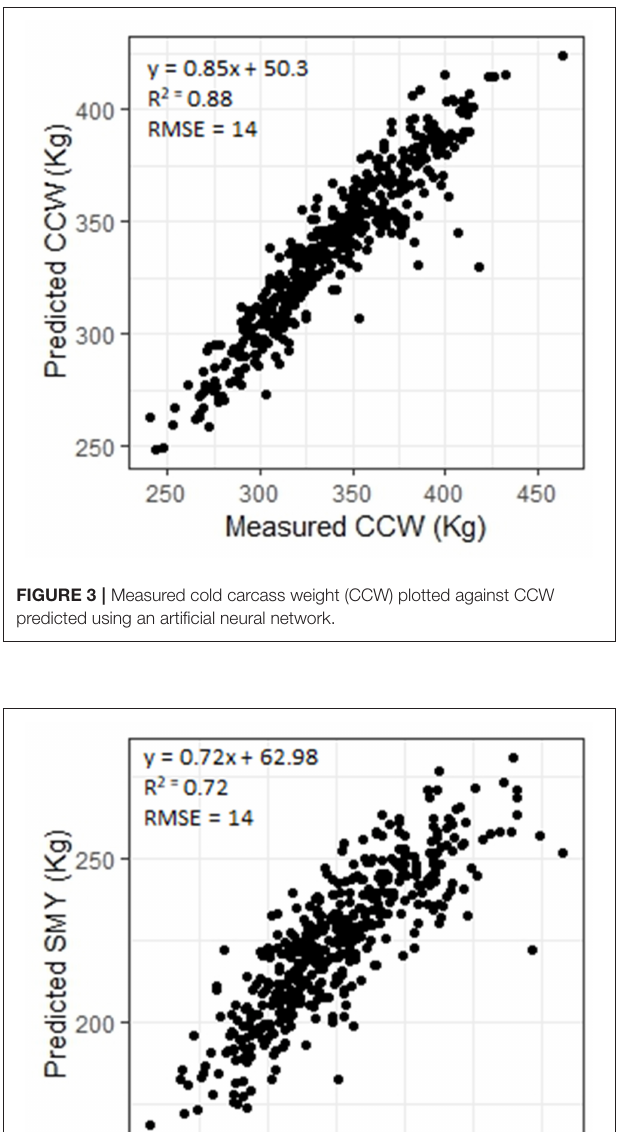
TABLE 3 | Relative importance (scaled from 100 to 0 where 100 is most influential in the model and 0 is redundant) of the 5 predictor variables with highest influence [and liveweight (LW), sex and breed type if not already included], for each ANN.